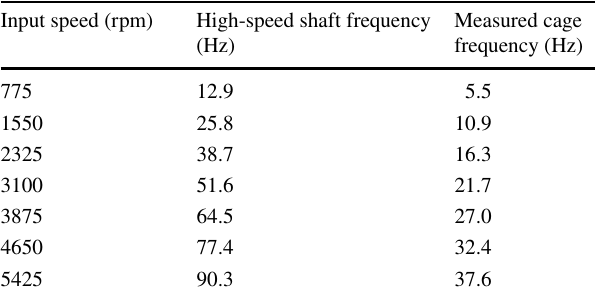
Table 2 The shaft frequency and measured cage frequency under different input speeds Input speed